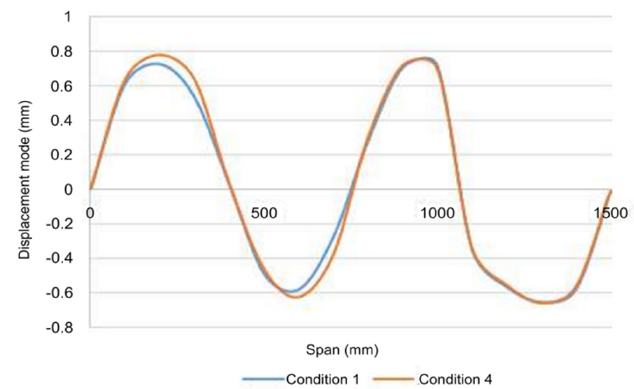
( d ) Comparison of the fourth-order vibration modes under Conditions 1 and 4.